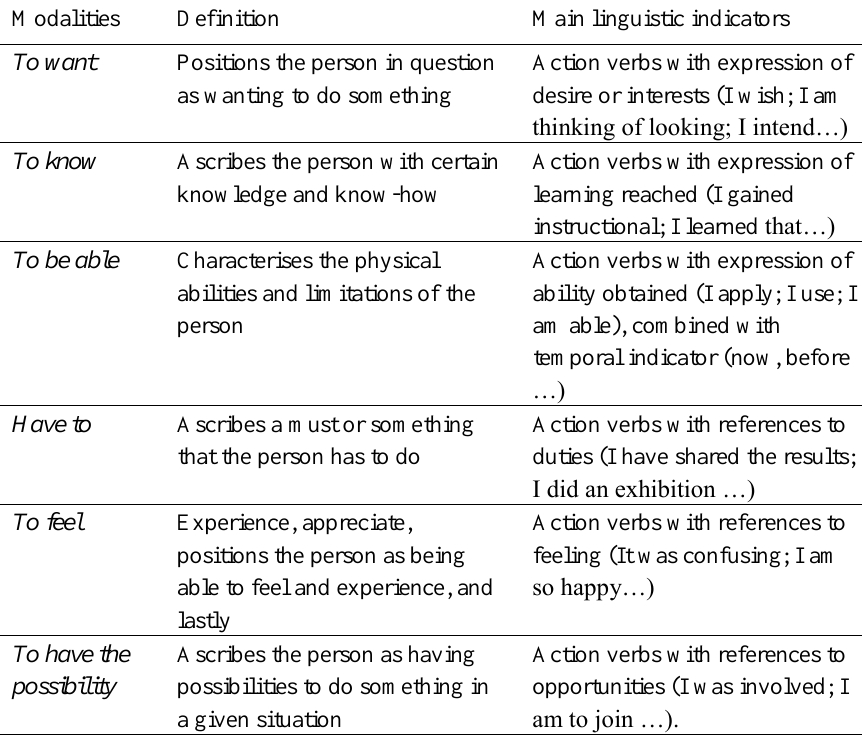
Guideline: Modalities, Definition and Indicators